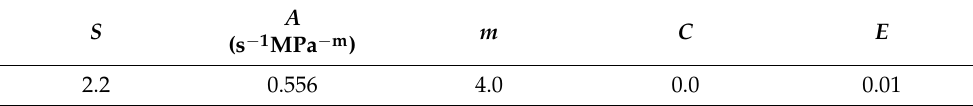
Table 4. Hysteresis parameters for the employed